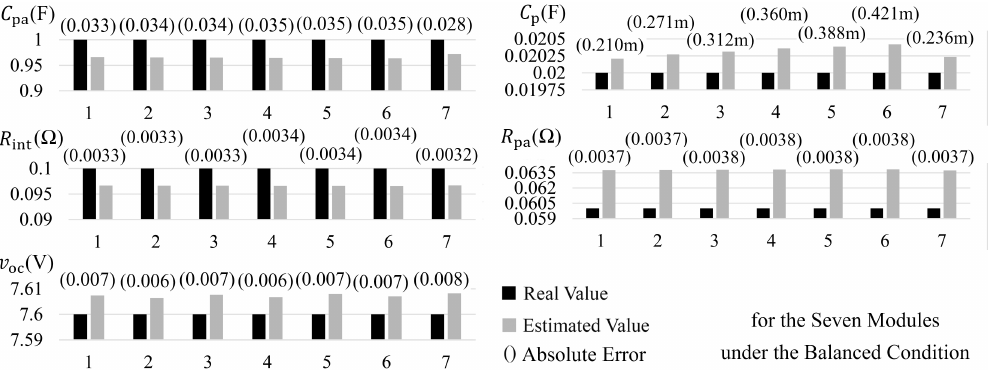
Figure 7. Estimation of the five parameters for the seven modules under the balanced condition.